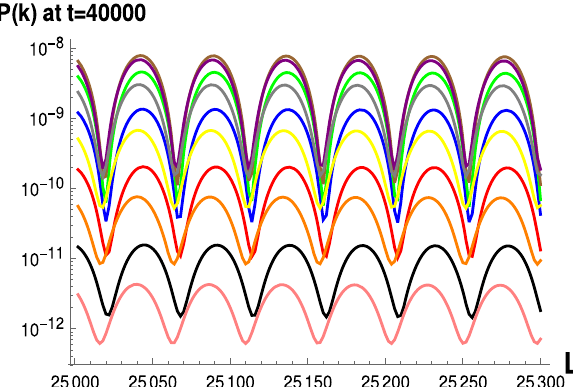
Fig. 5 The unnormalized probability density P ( k ) at k = 0 (black), 0.2 (red), 0.4 (blue), 0.6 (green), 0.8 (brown), 1.0 (purple), 1.2 (grey), 1.4 (yellow), 1.6 (orange) and 1.8 (pink) is plotted as a function of the baseline. It is obtained from Eq. (3.7) via numerical integration, and so does not use the approximations introduced in this note. One can see oscillations well beyond the putative maximum L max ∼ 3 × 10